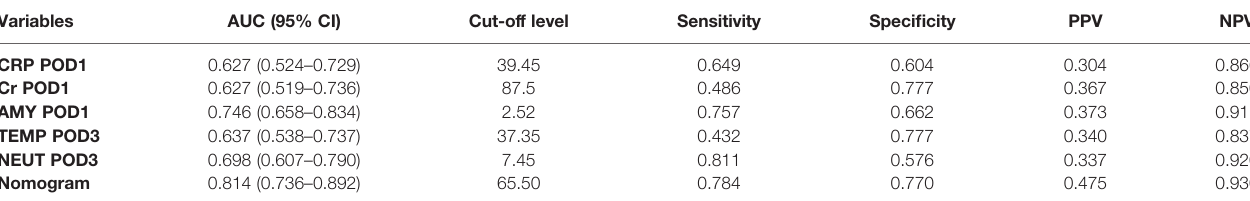
TABLE 3 | Discriminatory performance of CRP, Cr, AMY, TEMP, NEUT, and the formulated nomogram for detecting patients with CR-POPF after PD.